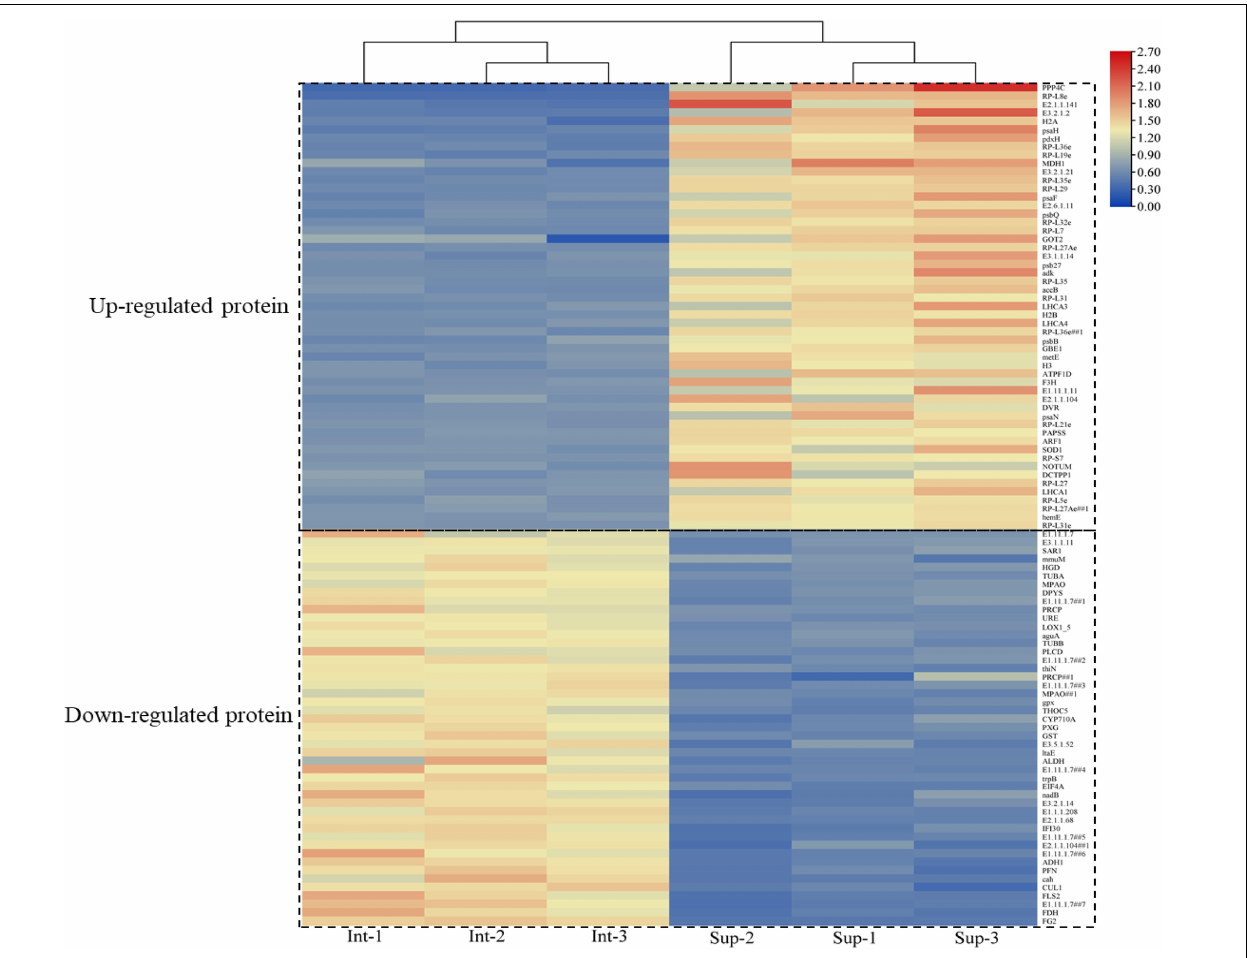
FIGURE 5 | Heatmap of the identified up- and downregulated proteins at different